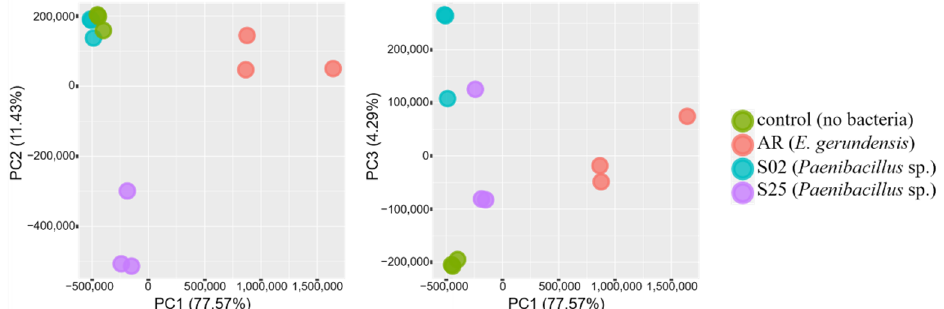
Figure 3. Principal component analysis (PCA) plots representing the clustering of biological replicates based on gene expression levels of barley seedling roots when using Nutrient Broth. Percentage variance explained by each axis is given in brackets. Seedlings co-incubated with strain AR ( E. gerundensis ) or S25 ( Paenibacillus sp.) are separated from the control seedlings along all three axes (PC1–PC3). However, seedlings co-incubated with strain S02 ( Paenibacillus sp.) are separated from the control seedlings only along the PC3 axis, which accounts for 4.29% of the total variances, suggesting strains AR and S25 triggered more obvious changes in transcriptome profiles of barley seedlings when compared with strain S02.